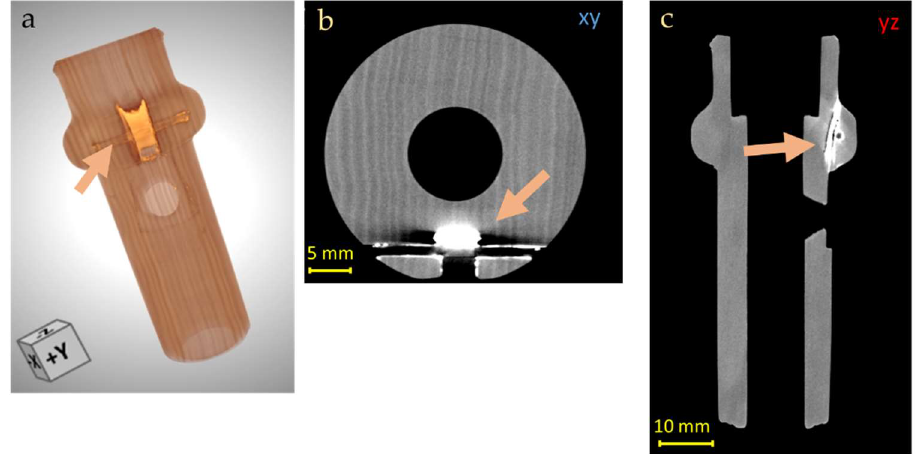
Figure 10. 3D render ( a ) and CT horizontal ( b ) and lateral ( c ) slices of the Transverse Flute foot, in which the metallic residues from the brass key insertion are observed (orange arrows). In the 3D rendering ( a ), the metallic residues are also clearly visible in the upper part of the model.